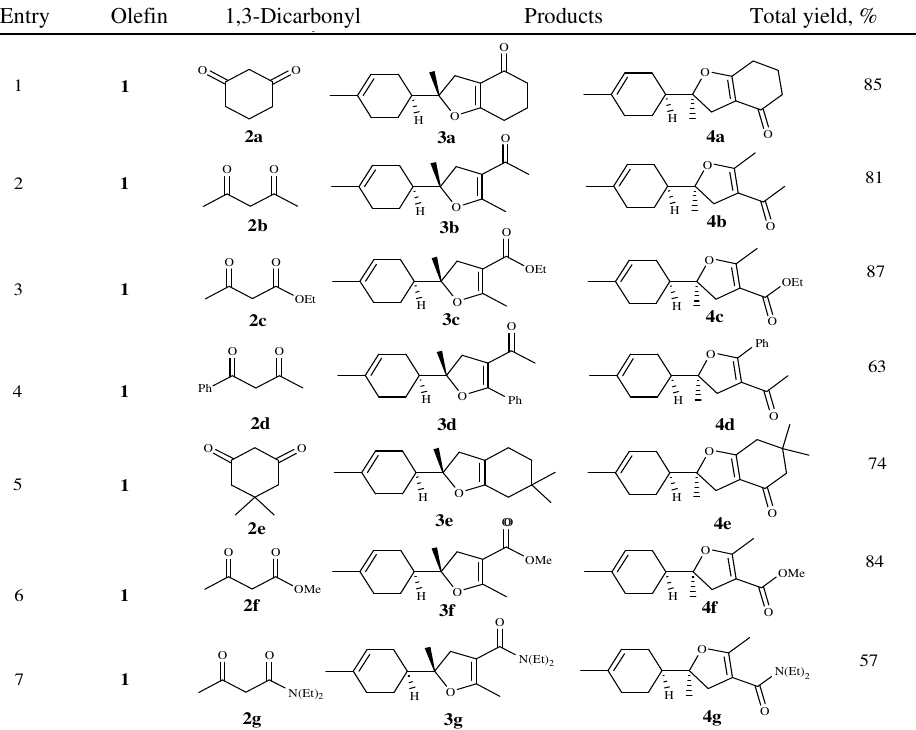
Table. 1. Synthesized